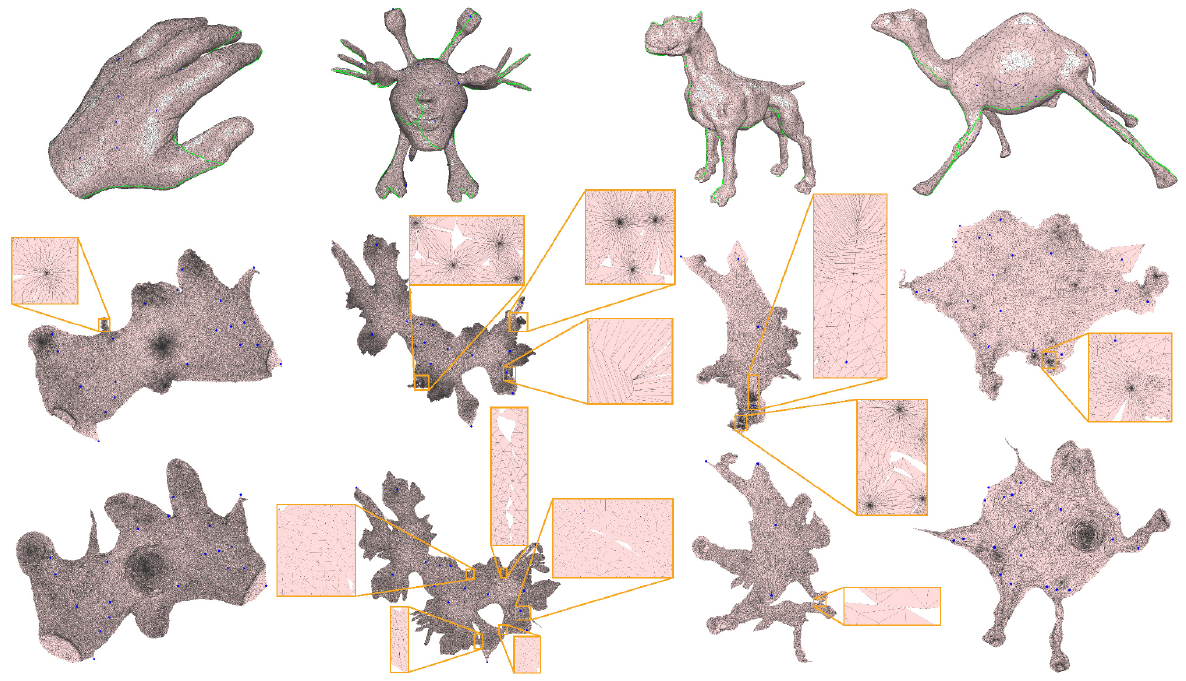
Fig. 13 Comparisons of our results with those of Ref. [16], while applying the same constraints to four meshes. Top row: input meshes. Middle row: the results of Ref. [16]; they contain self-intersections or flips. Bottom row: our results are globally injective.